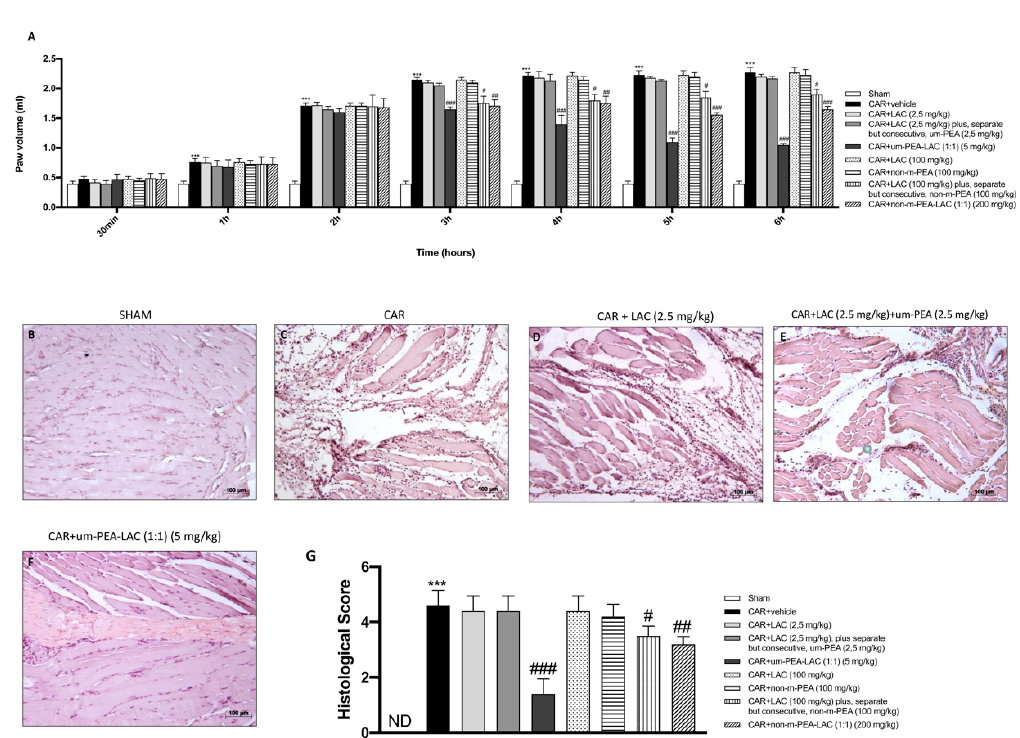
Figure 1. Efficacy of um-PEA and LAC treatment on the time course of CAR-induced paw edema and histological analyses. Um-PEA and LAC (5 mg/kg) significantly reduced CAR-induced paw edema already after 3 h after from CAR injection and thereafter for each time points compared to the CAR-injected group. A less but significant reduction was achieved by treatment with CAR + LAC (100 mg/kg) plus, separate but consecutive, non-m-PEA (100 mg/kg), and CAR + non-m-PEA and LAC groups (1:1) (200 mg/kg). No significant differences were noted in all other groups compared with the vehicle group ( A ). CAR-treated paws showed edema and tissue injury ( C , G ) compared to the control ( B , G ). Um-PEA and LAC 5 mg/kg treatment significantly reduced tissue injury ( F , G ); the reduction in CAR-tissue damage was also appreciable in treatments with LAC (100 mg/kg) plus, separate but consecutive, non-m-PEA (100 mg/kg), and more with non-m-PEA and LAC groups (1:1) (200 mg/kg) (data not shown). Other oral treatments did not show any protection in histological injury induced by CAR injection ( D , E , G and data not shown). Data are representative of at least three independent experiments. Values are means ± SEM. One-Way ANOVA test. *** p < 0.001 vs. sham; # p < 0.05 vs. CAR; ## p < 0.01 vs. CAR; ### p < 0.001 vs. CAR. ND not detectable.